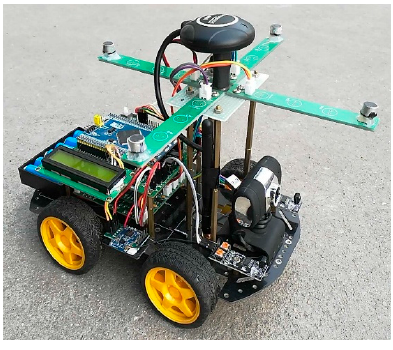
Figure 11. The four-element cross-microphone array.